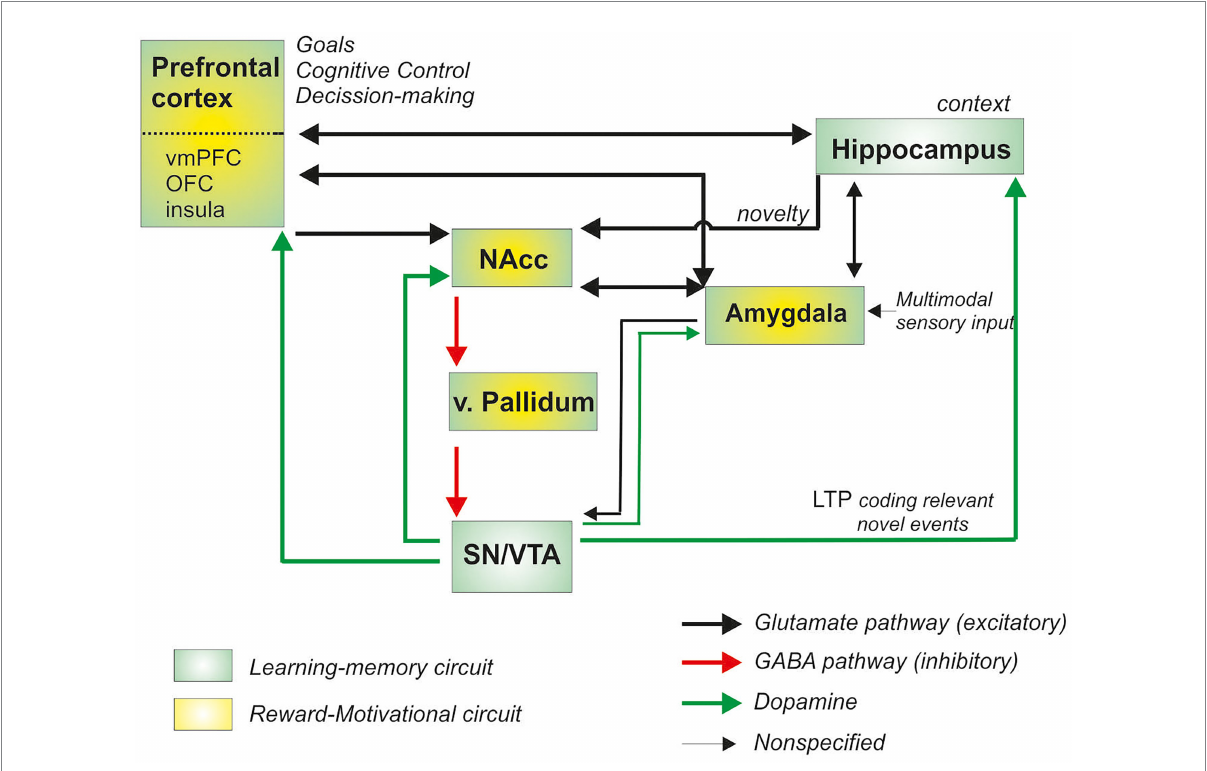
FIGURE 1 Schematic representation of the brain regions involved in reward processing (adapted and modified from Kelley, 2004; Lisman and Grace, 2005; Camara et al., 2009; Mallorquí et al., 2014; green-yellow boxes; NAcc, Nucleus Accumbens; vmPFC, ventromedial prefrontal cortex; OFC, orbitofrontal cortex; SN Substantia nigra; VTA ventral Tegmental Area; LTP, long-term potentiation; v,